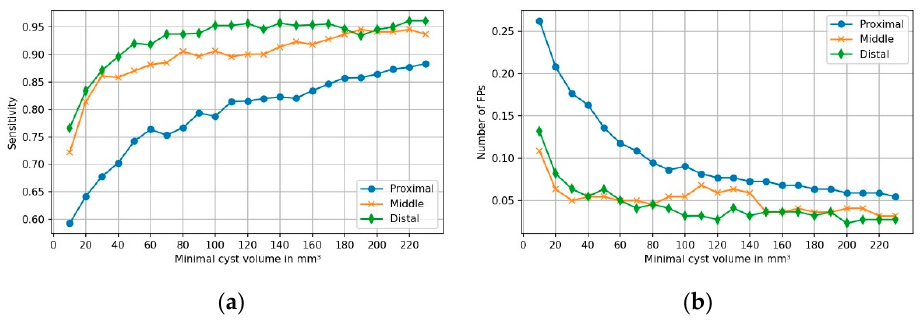
Figure 5. ( a ) Sensitivity and ( b ) false positive (FP) rate of model’s predictions as a function of cyst volume, for each region of the pancreas.